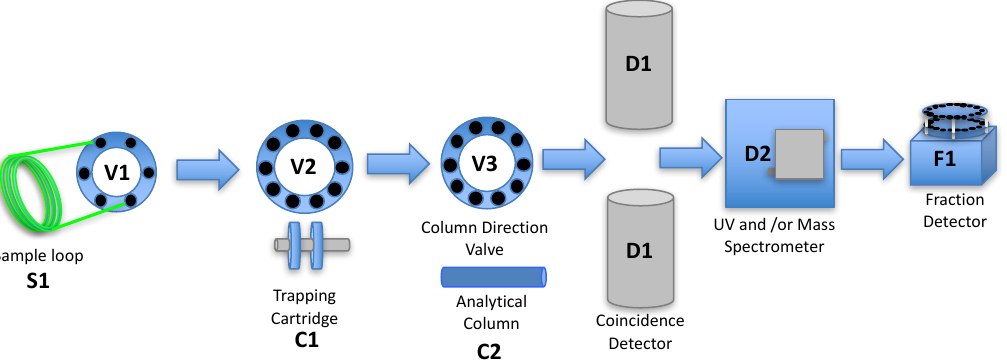
Figure 1. Flow chart of the processing of a metabolite sample. The plasma sample loaded on to the Sample loop S1 is transferred to the trapping cartridge C1. The materials retained on the trapping cartridge are then separated on the Analytical column C2. All materials from the trapping cartridge and the analytical column are passed through the coincidence detector D1 and UV and/or Mass Spectrometer D2 and collected in the fraction collector F1 for analysis in a well